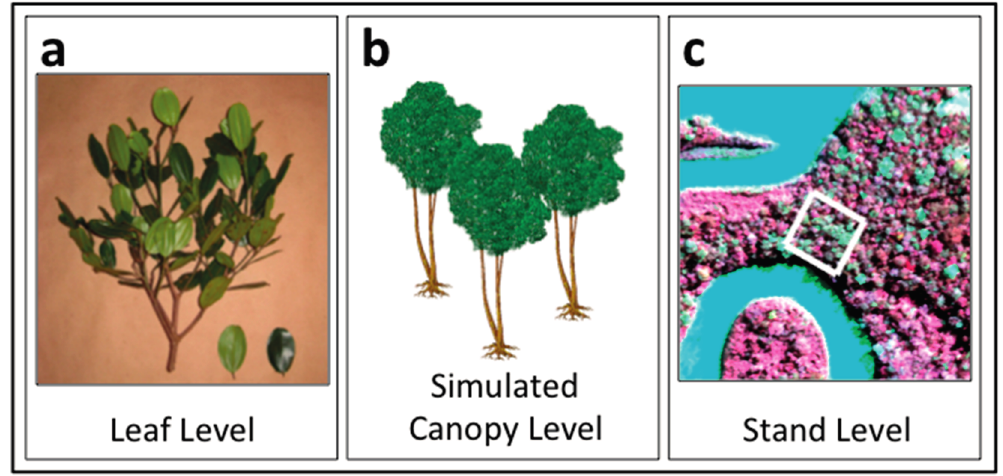
Figure 1. Overview of our three-tier approach to estimate non-structural carbohydrates at ( a ) leaf, ( b ) simulated canopy and ( c ) forest stand